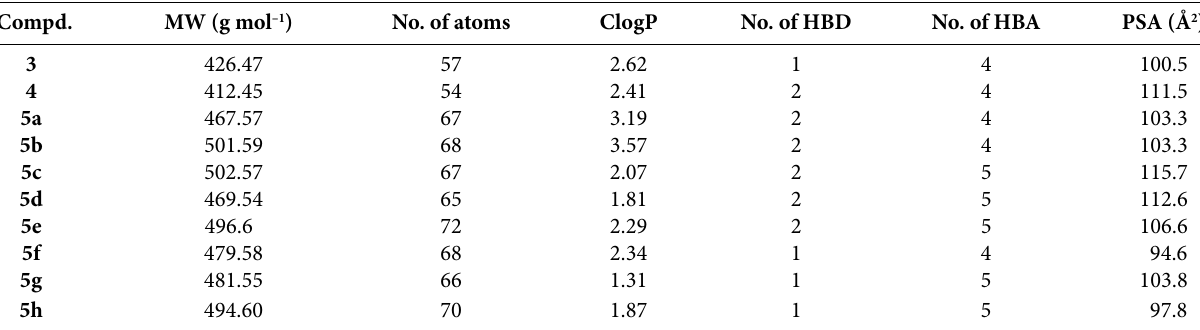
Table 1. Calculated physicochemical properties of compounds 3 , 4 , and 5a – h .